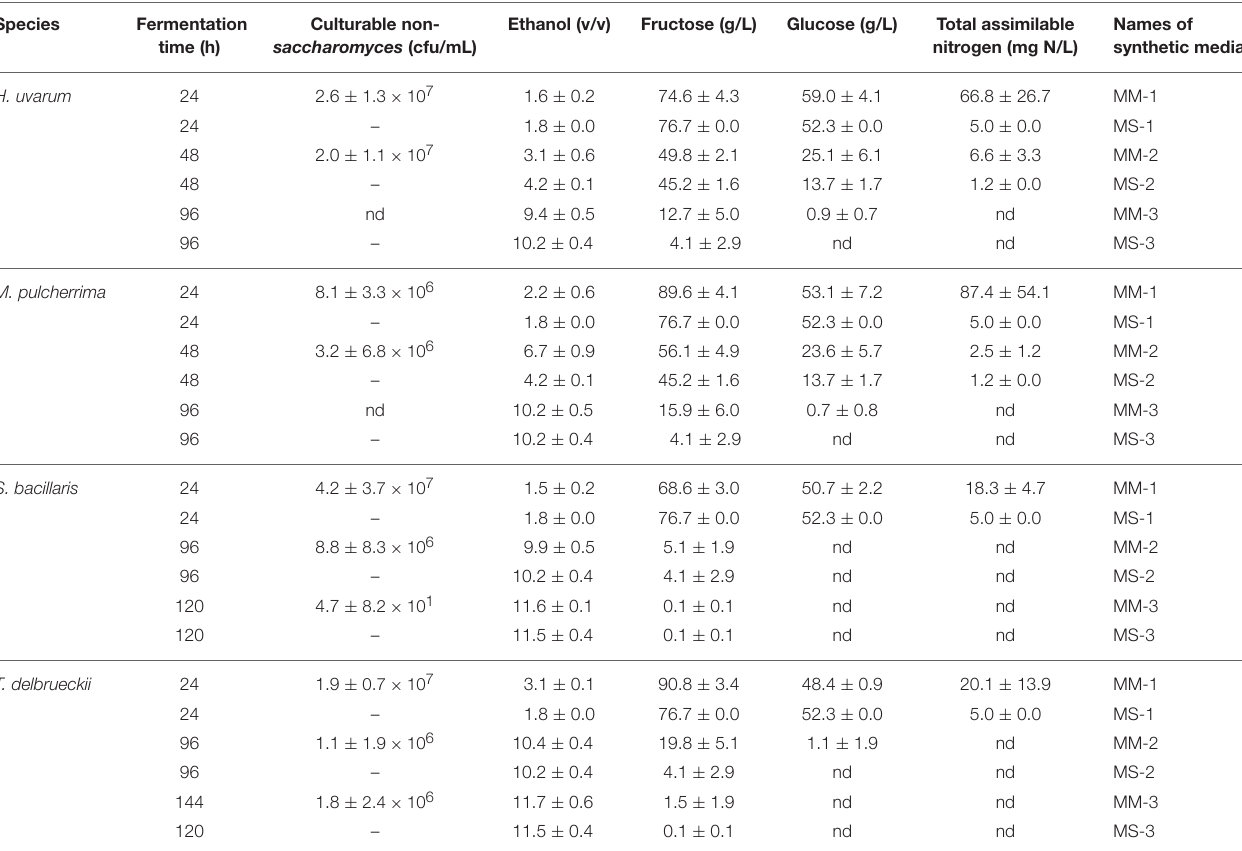
TABLE 1 | Fermentation stages, population size and chemical characteristics of the media at different single and mixed fermentation stages.